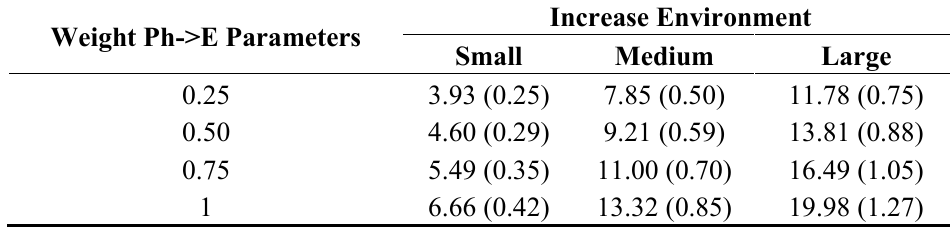
Table 7. Raw phenotypic mean changes (std units) as a function of weight given to the Ph->E transmission parameters ( w = 0.25, 0.50, 0.75) and different environmental means. αγ Environmental means at t = 1 is defined as a function of standard deviation of perf IQ = 15.71, Small = sd * 0.25, Medium = sd * 0.50 and Large = sd * 0.75). (sd perfIQ perfIQ perfIQ perfIQ Environmental means at t + 1 are calculated according to Equations (14) and